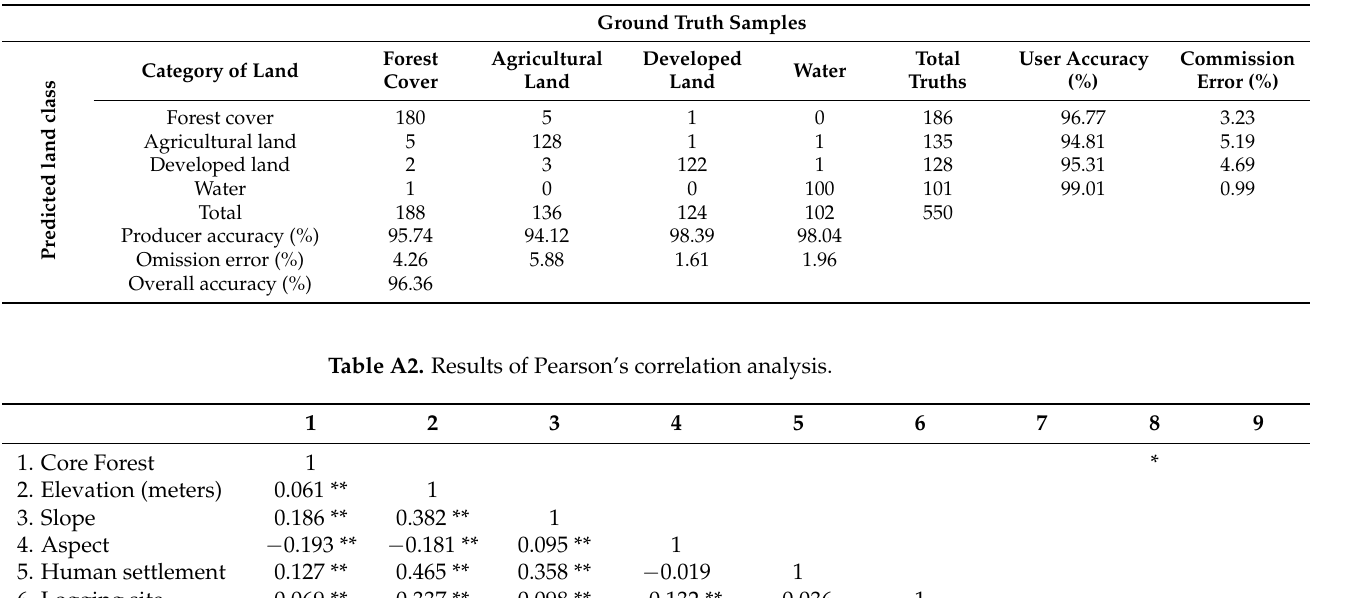
Table A1. Results of the accuracy assessment of classified Landsat image from the Atewa Range Forest Reserve.